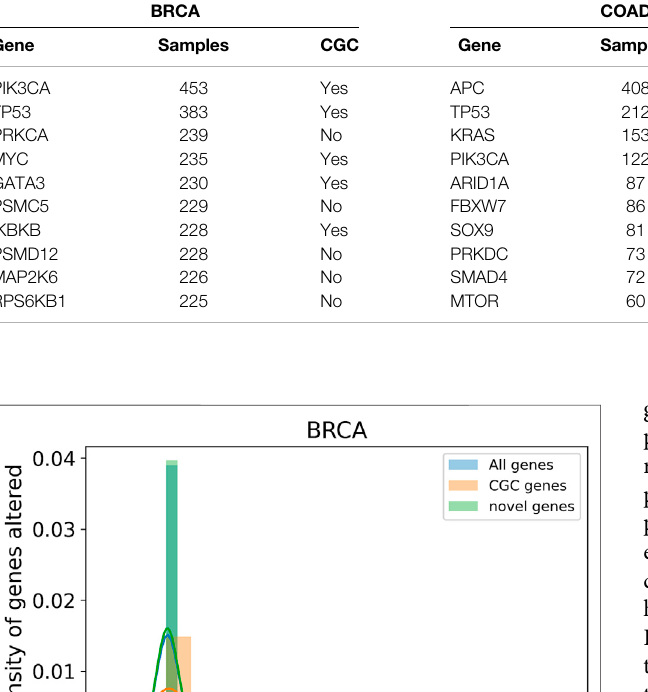
TABLE 5 | Top genes identi fi ed for all cancer types. The genes are listed along with the number of samples they were labeled TSGs or OGs. Their presence or absence in CGC is also given. BRCA COAD